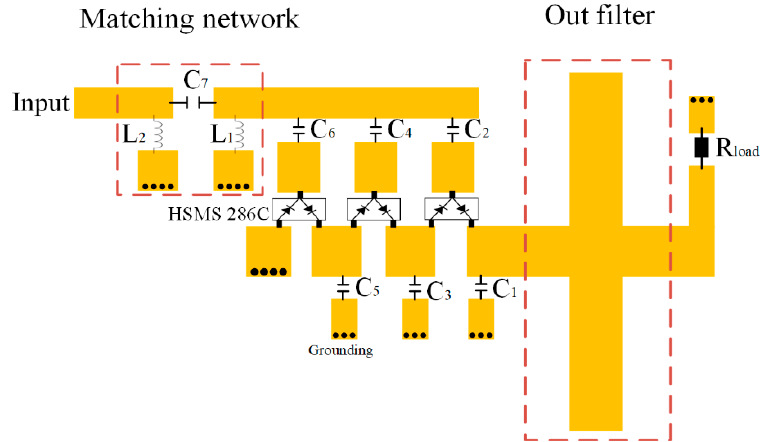
Figure 15. Configuration of the proposed rectifying circuit.